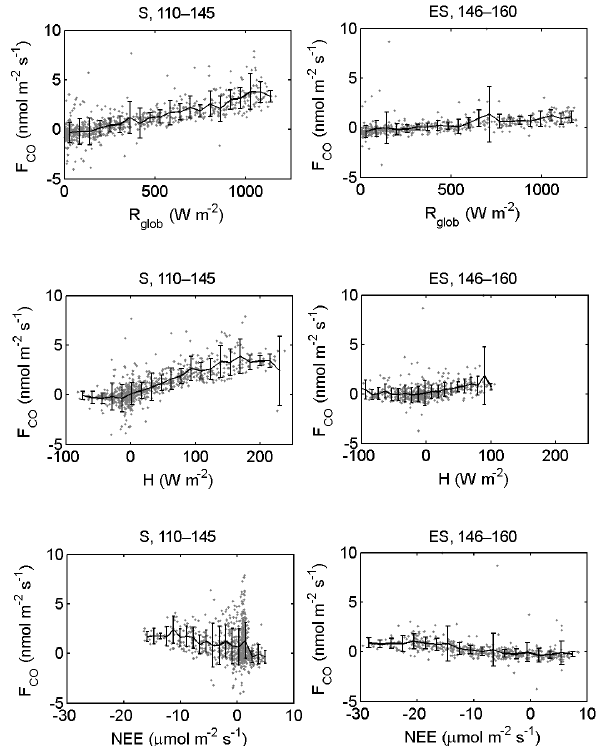
Figure 5. Daytime half-hour average CO fluxes ( F CO ) against global radiation ( R glob ) , sensible heat flux ( H ) and net ecosys- tem exchange of CO 2 (NEE) measured over two emission periods (spring, days 110–145, early summer, days 146–160) at the reed canary grass crop in Maaninka. The bin averages with ± 1 SD are presented in black